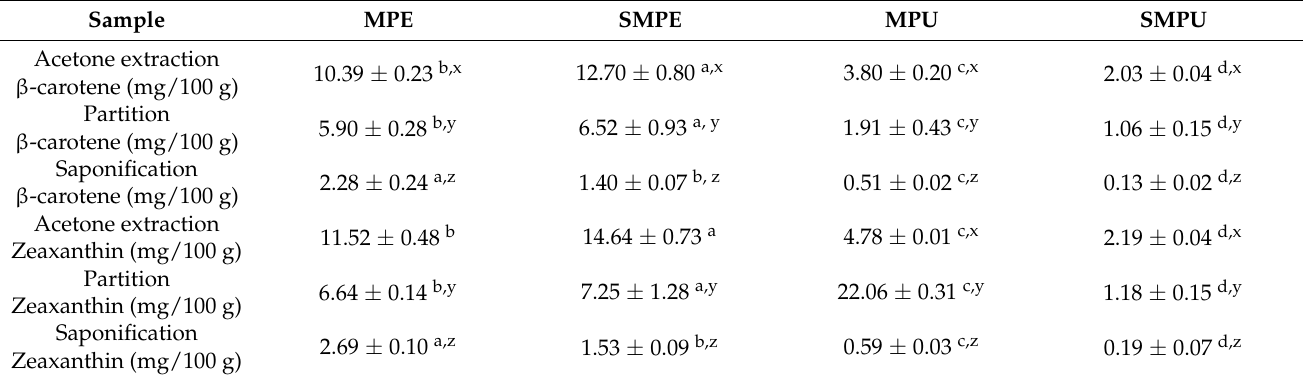
Table 5. Carotenoids contents of umbu by-products for each analytical